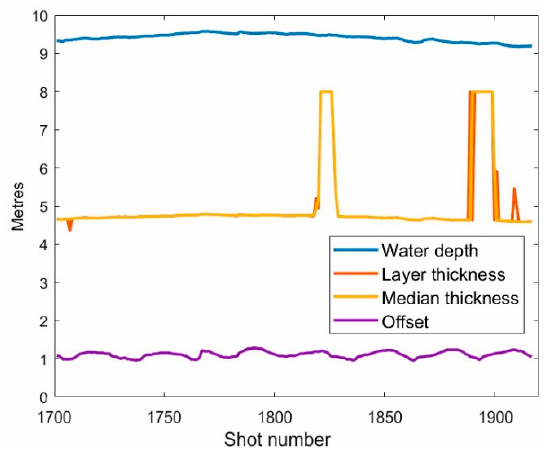
Figure 10. Estimated water depth (blue line), layer thickness (red line), layer thickness after a 7-term median filtering (yellow line) and estimated offset from the direct arrivals (violet